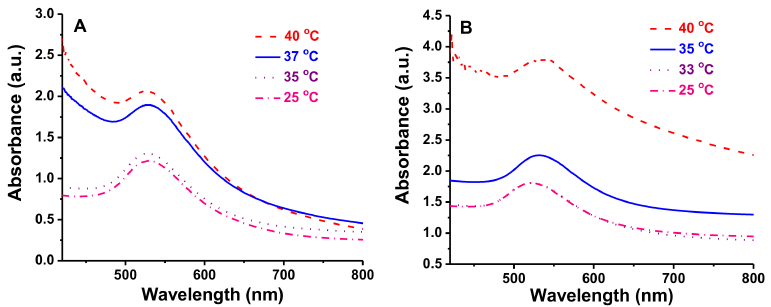
Figure 9. UV-vis absorption spectra of PNIPAM-PLL-AuNPs at various temperature at pH = 2.0 ( A ) and pH = 12.0 ( B ) (Concentration: 2.0 mg/mL).